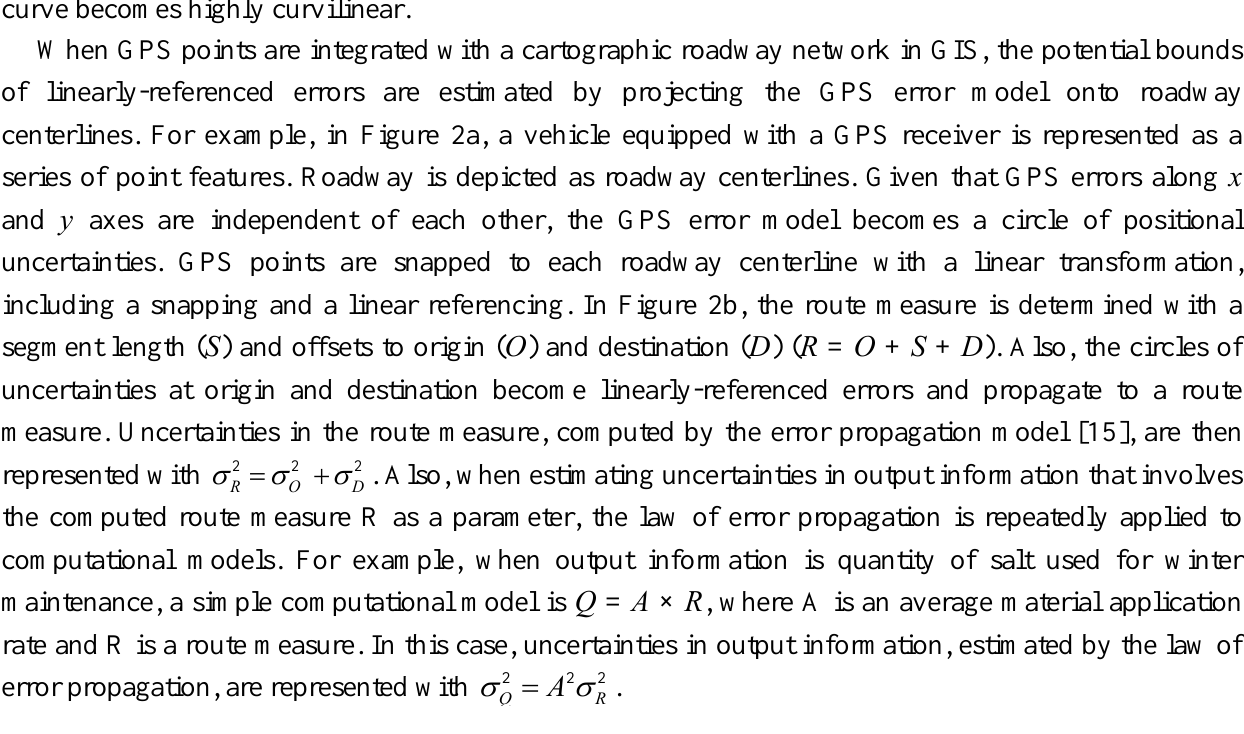
Figure 2. Uncertainty propagation in GPS and GIS applications for transportation. ( a ) GPS data points along roadway centerlines; and ( b ) Route measure